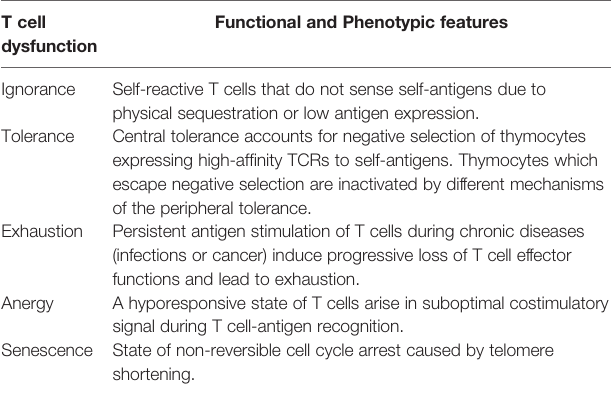
TABLE 1 | Classi fi cation of dysfunctional T cells. T cell